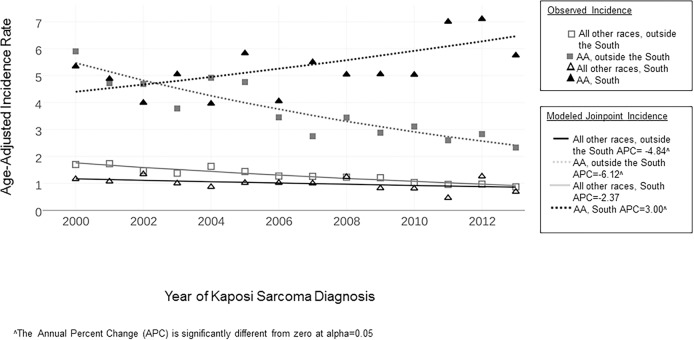
KS incidence in the U.S. by race and geographic, 2000–2013.